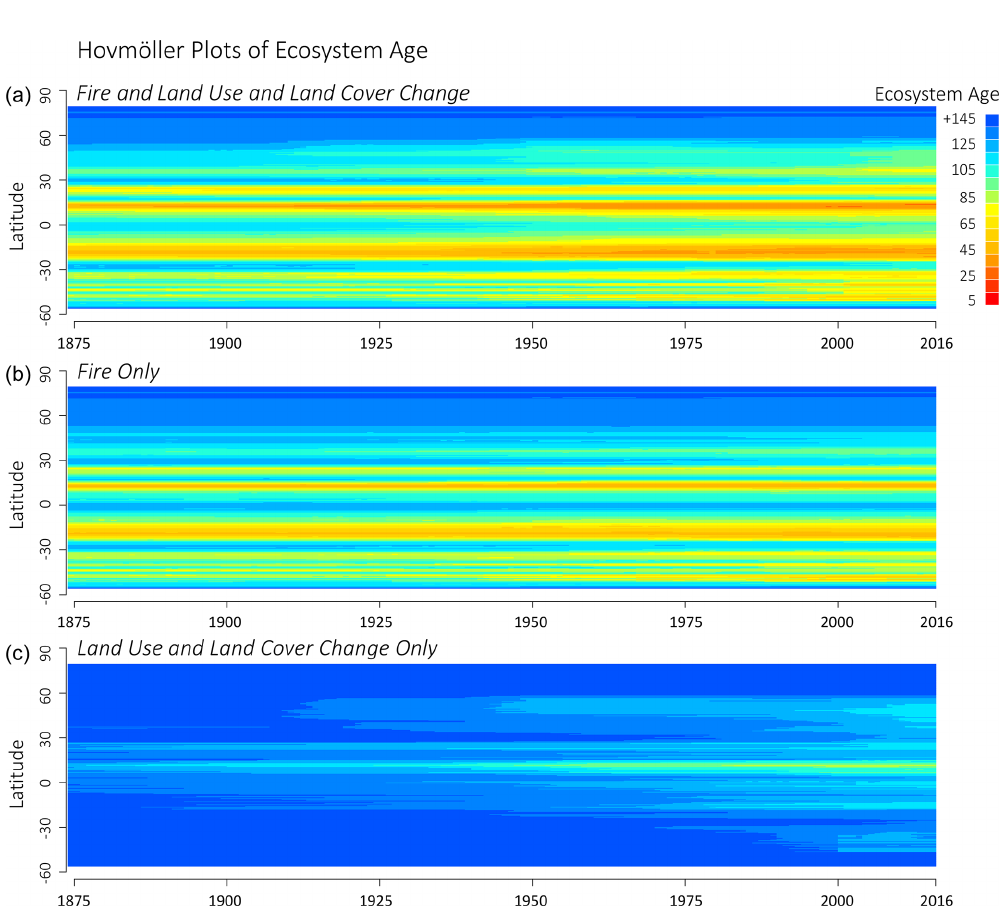
Figure 8. Zonal ecosystem age versus year based on LPJ-wsl v2.0 simulations using full forcing (a) , only fire (b) , or only land-use and land-cover change (c)